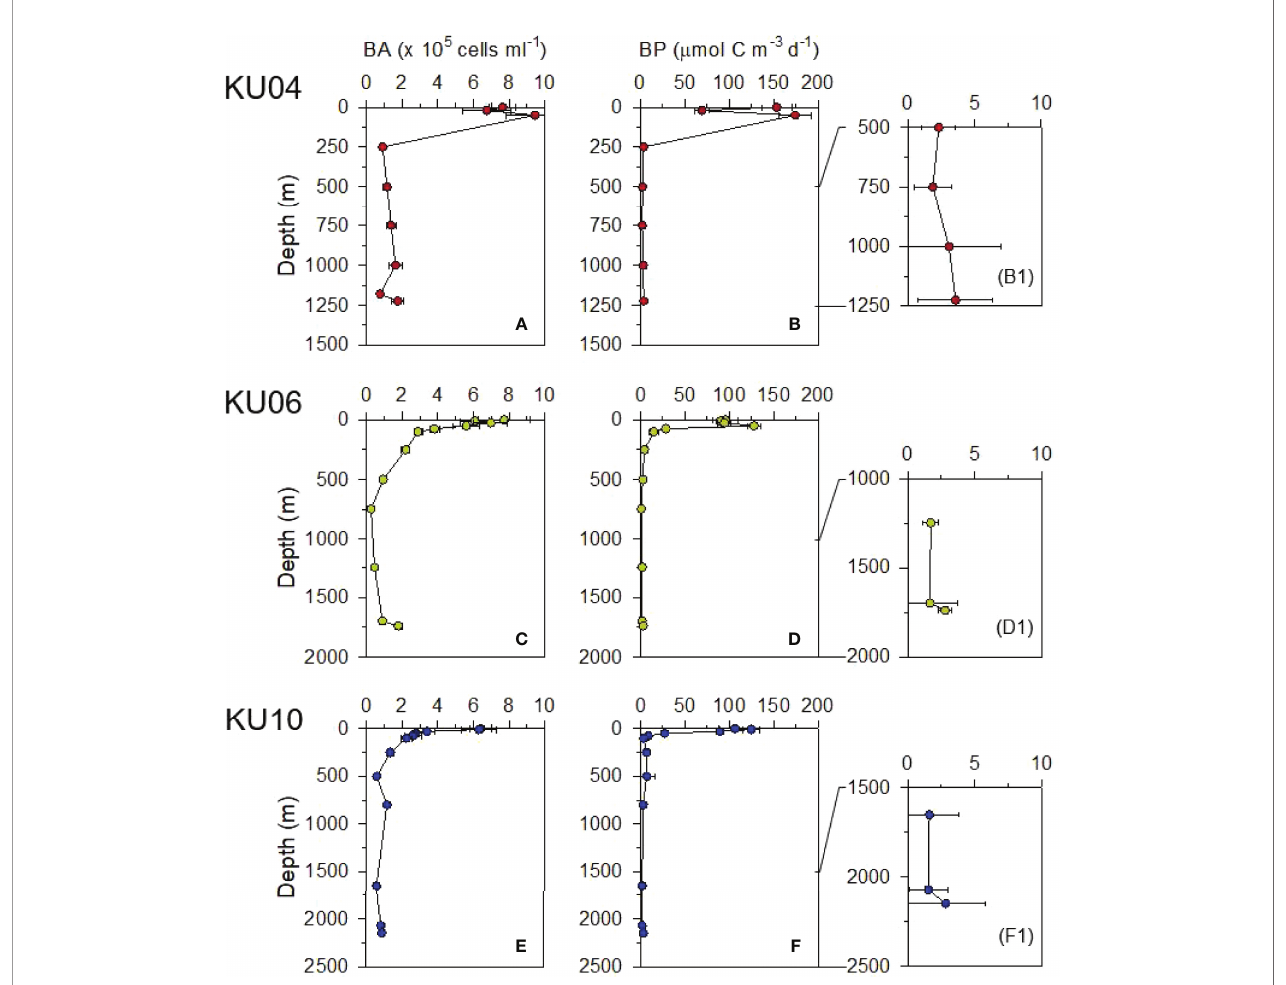
FIGURE 5 | Vertical pro fi les of bacterial abundance (BA; A , C and E ) and bacterial production (BP; B , D and F and B1 , D1 and F1 ) in the water